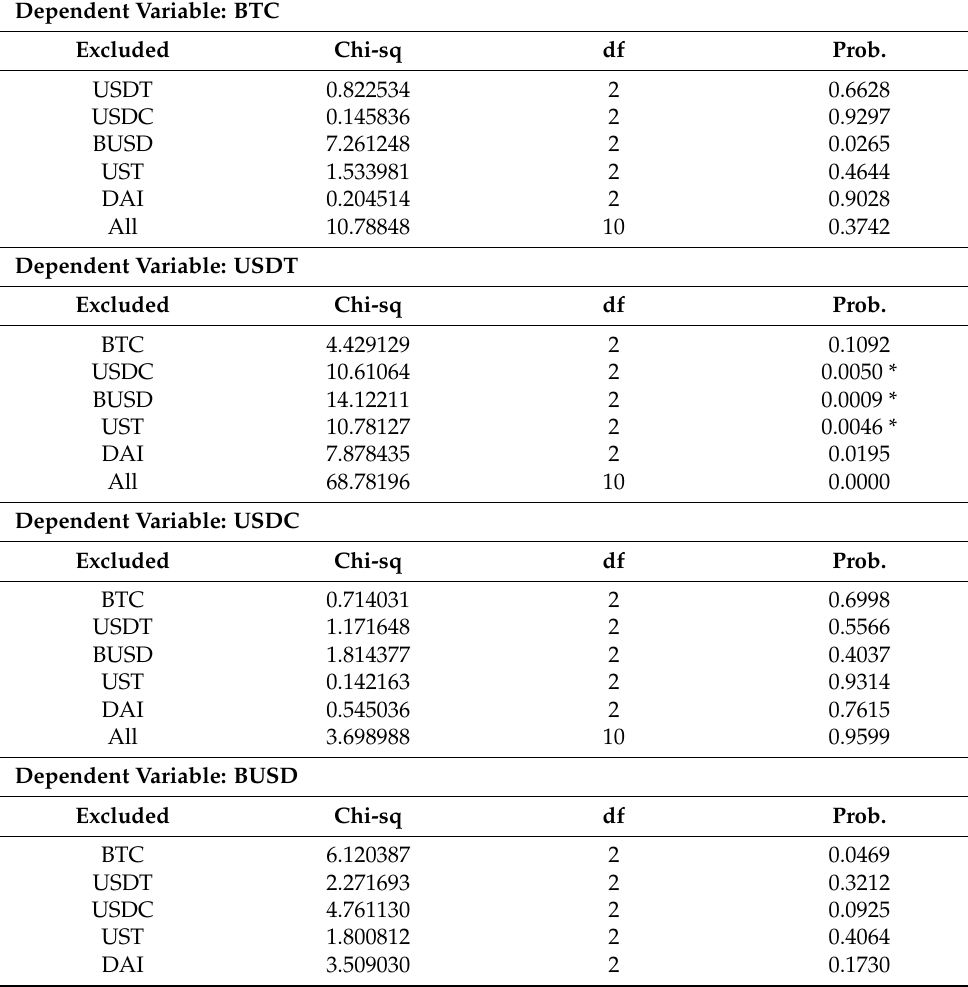
Table 5. VAR Granger causality tests for BTC and